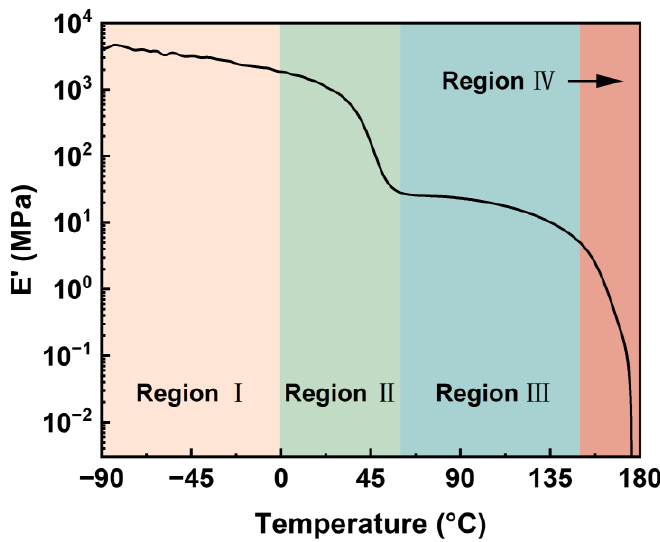
Figure 3. Storage modulus of HD-TPU as a function of temperature.